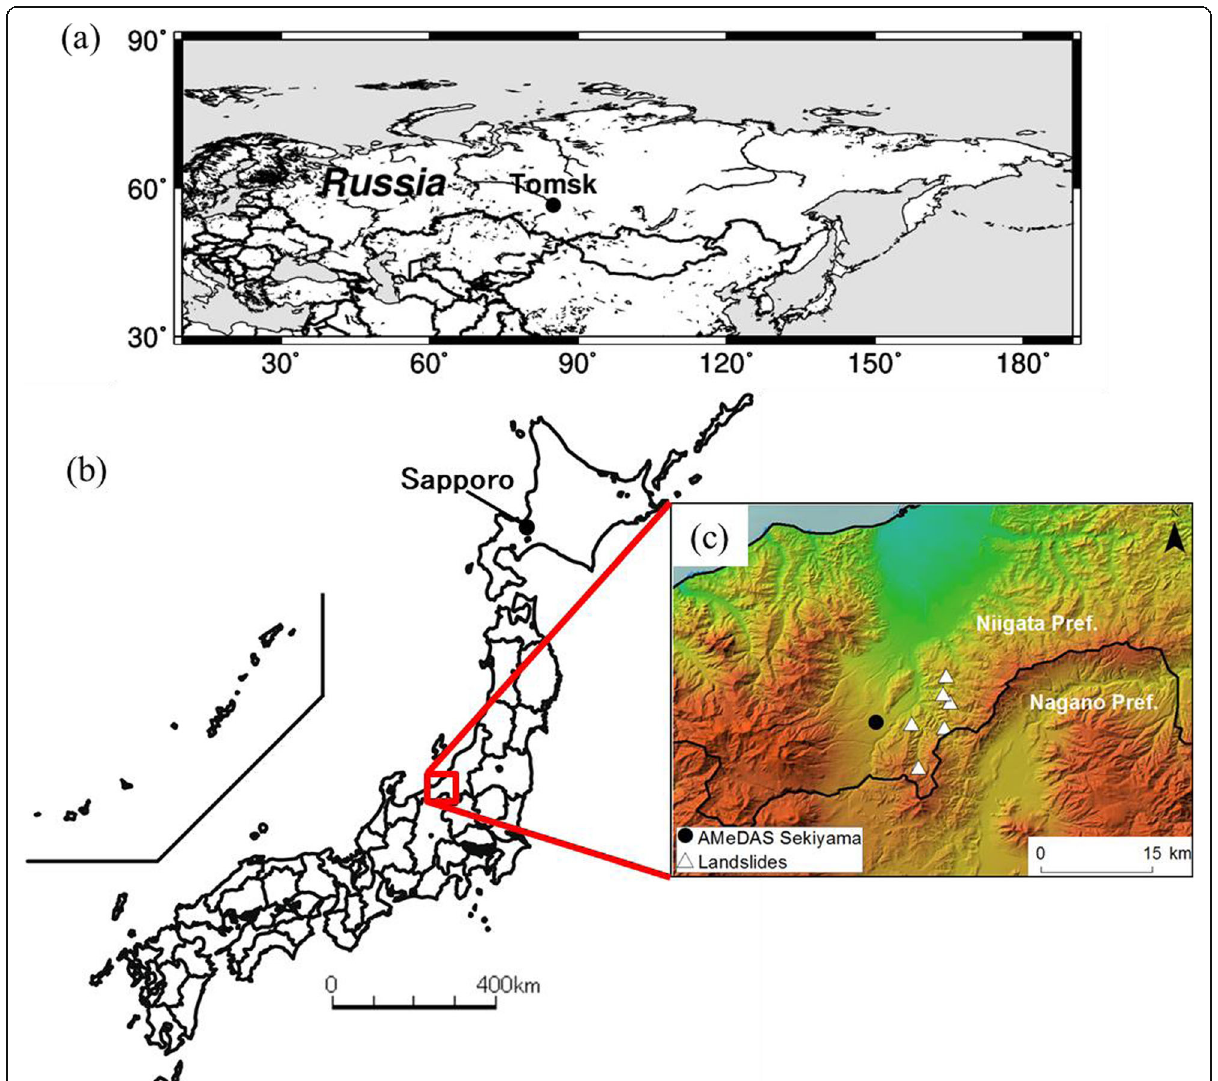
Fig. 2 Study area: a Tomsk, Russia. b Japanese islands with prefectural boundaries. The position of Sapporo is also indicated. c Distribution of snowmelt-driven landslide disasters around the Sekiyama region in 2006. AMeDAS is the abbreviation of Automated Meteorological Data Acquisition System operated by the Japan Meteorological